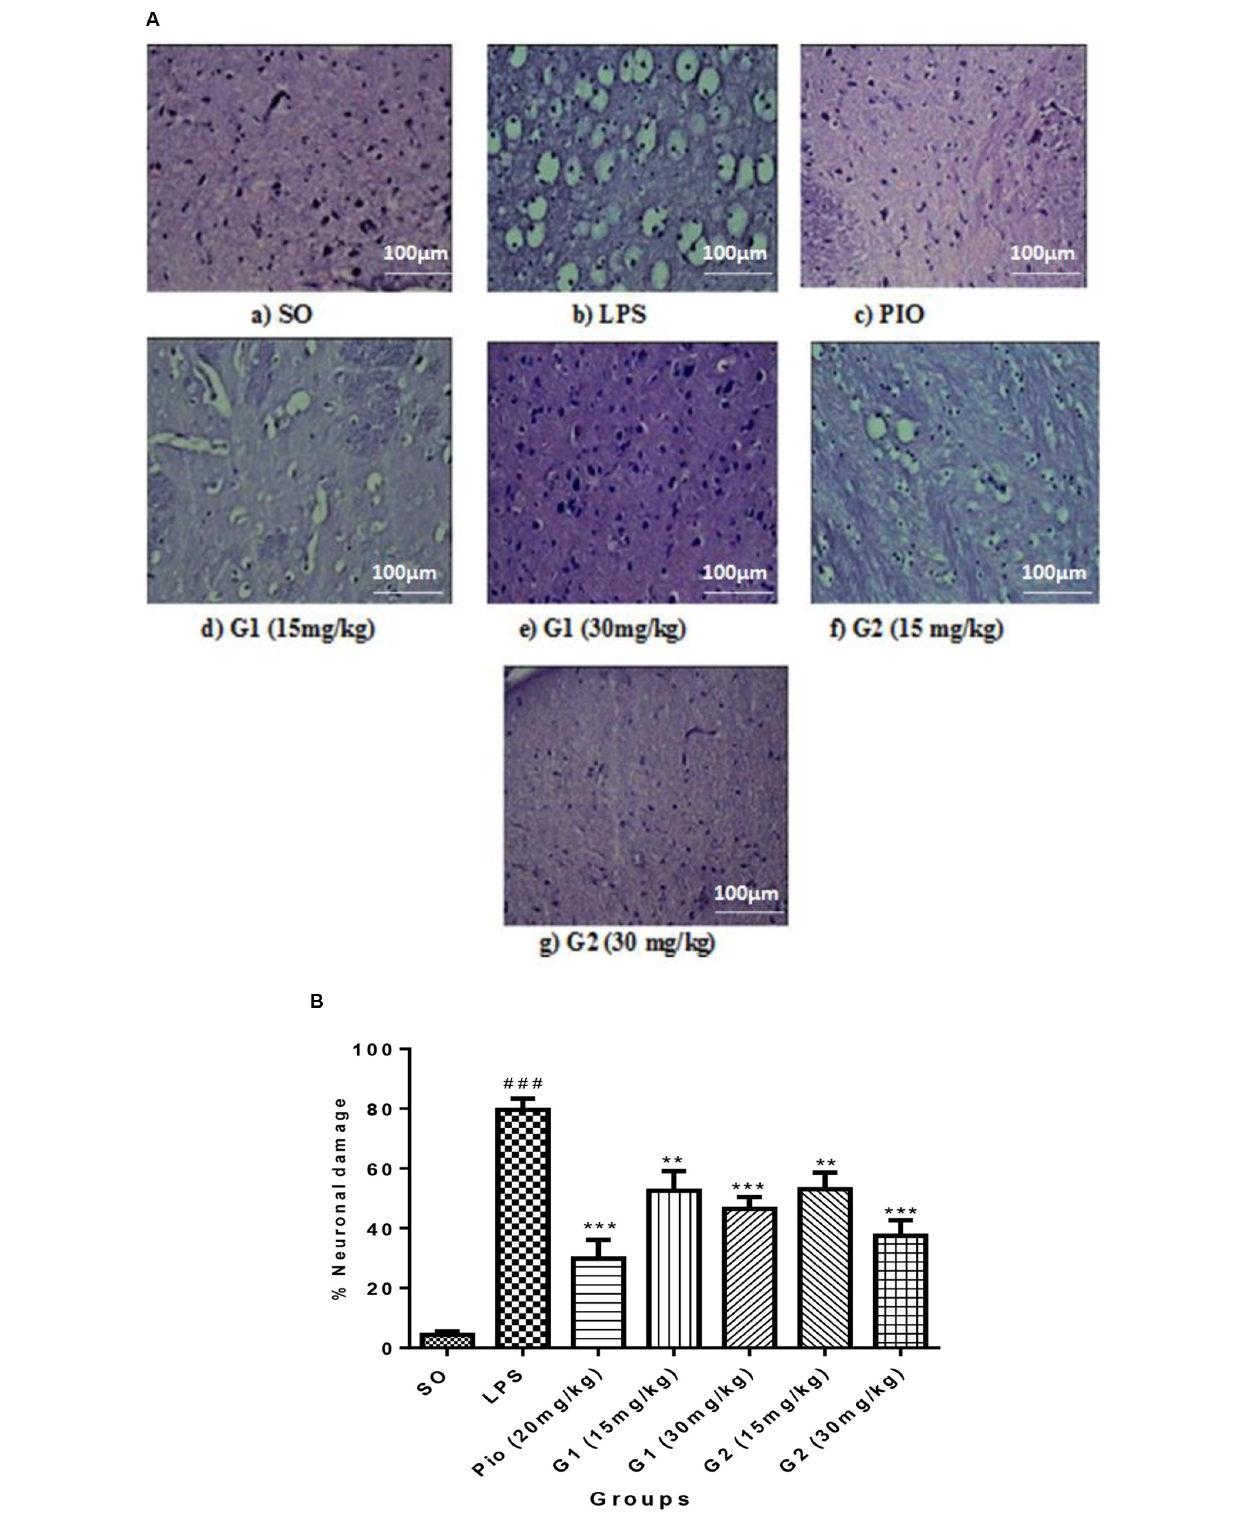
FIGURE 7 | (A) Sections of the cortex region of the brain stained with hematoxylin and eosin staining. (B) Quantification of neuronal damage. Values are expressed as mean ± SEM. Statistical significance was determined by one-way ANOVA followed by Bonferroni’s multiple comparison tests. Superscript ### denotes p < 0.001 vs. SO; ** and *** denote p < 0.01 and p < 0.001 vs. LPS, respectively. SO, sham operated; LPS, lipopolysaccharide; Pio, pioglitazone; G, glitazones.